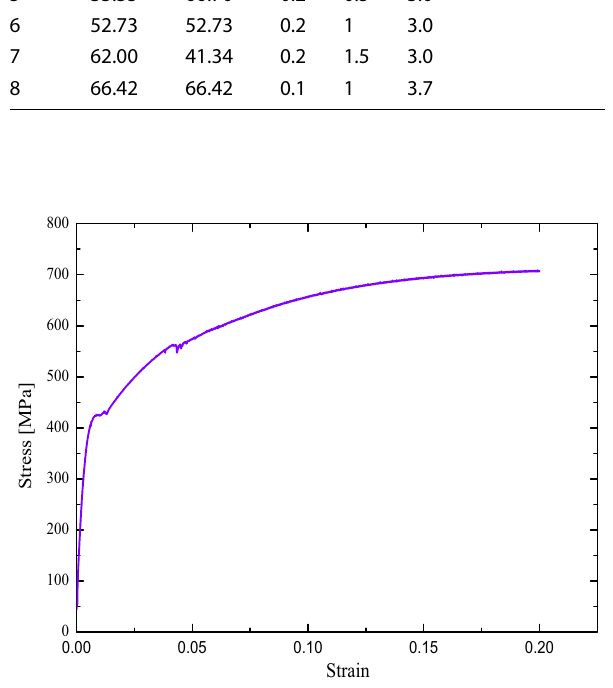
Fig. 5 Tensile stress–strain curve of the Q235 steel specimen